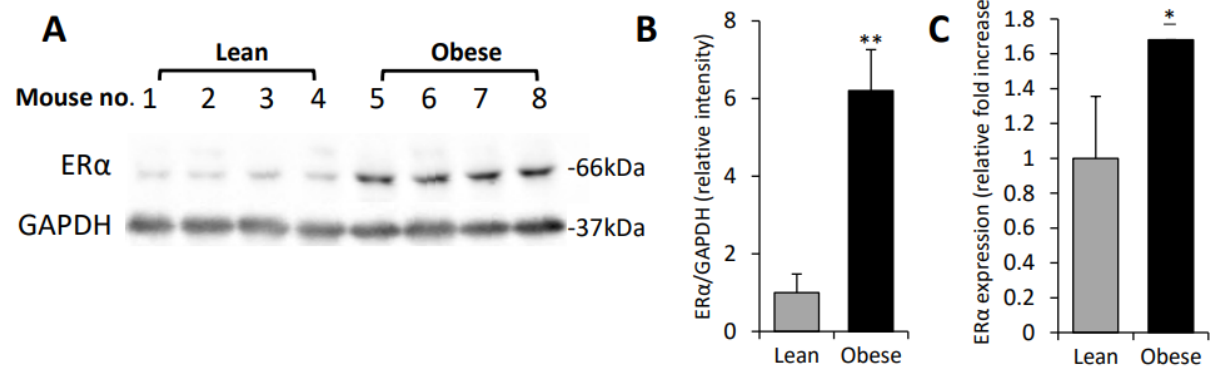
Figure 1. Upregulation of ER α in obesity-associated murine breast carcinoma model. Female C57BL6 mice fed for 12 weeks with either HFD (obese) or control diet (lean), were injected with E0771 cells into the 4th mammary fat pad of all mice, as described in Methods. Tumors were harvested 14 days post cell injection and lysates of tumor tissue derived from lean and obese mice were analyzed for ER α expression by immunoblotting and qRT-PCR. ( A ) Protein levels of full length 66 kDa ER α in the orthotopic E0771 tumors derived from lean and obese. ( B ) The band intensity was quantified using ImageJ software; intensity ratio for ER α /GAPDH is shown, n ≤ 4 mice per condition. ( C ) qRT-PCR was used to determine the levels of ER α mRNA in tumor tissue samples collected from lean and obese mice. Error bars represent ± SD. * p < 0.04; ** p < 0.001.